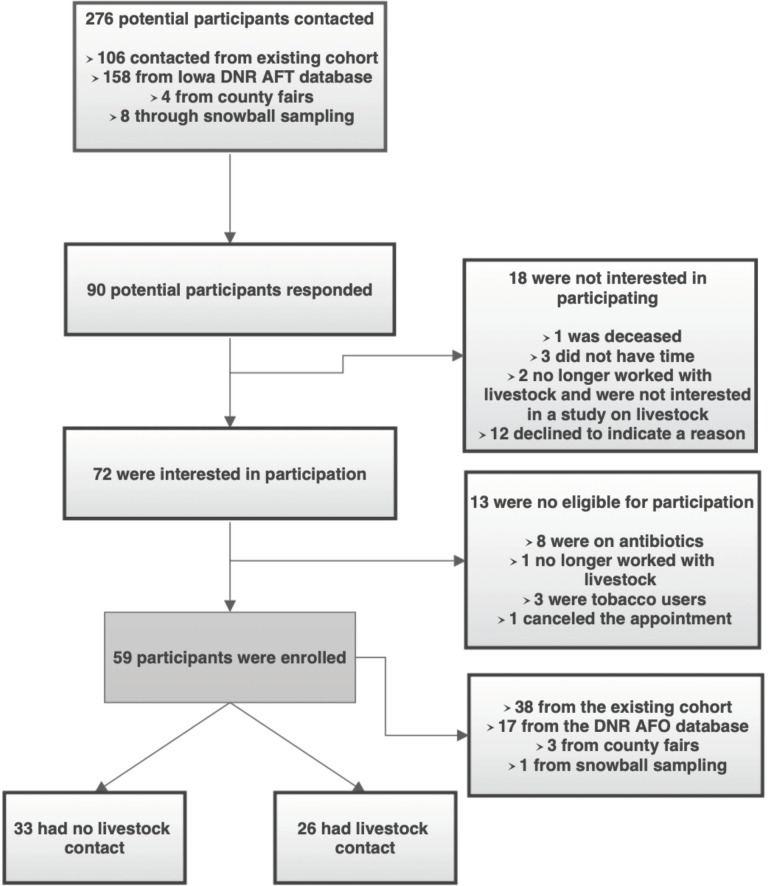
Flow diagram of participant enrollment.